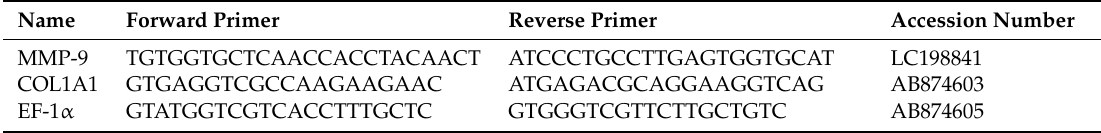
Table 1. Primer sequences for real-time quantitative